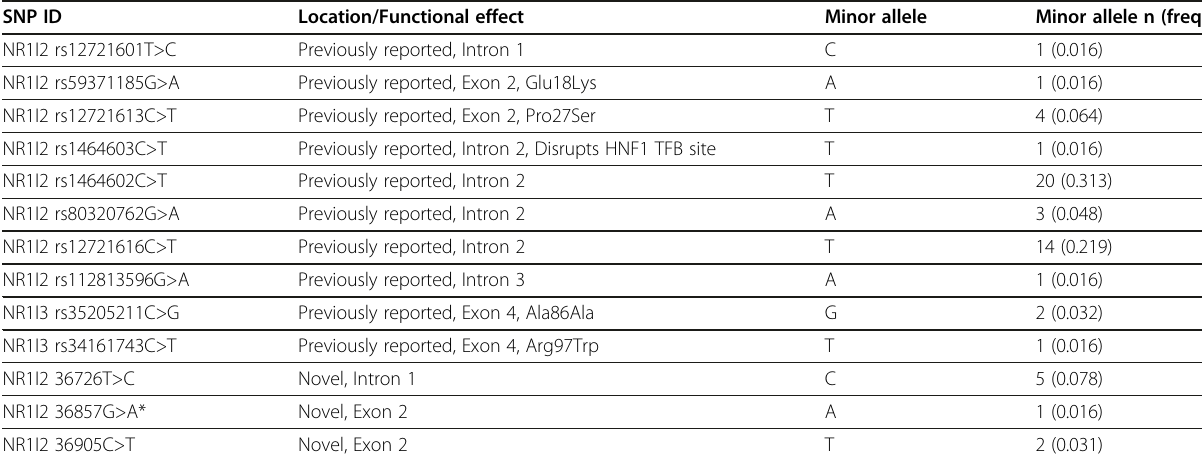
Table 3 NR1I2 and NR1I3 genetic variants in 32 HIV/AIDS patients following targeted sequencing of the NR1I2 and NR1I3 DNA binding